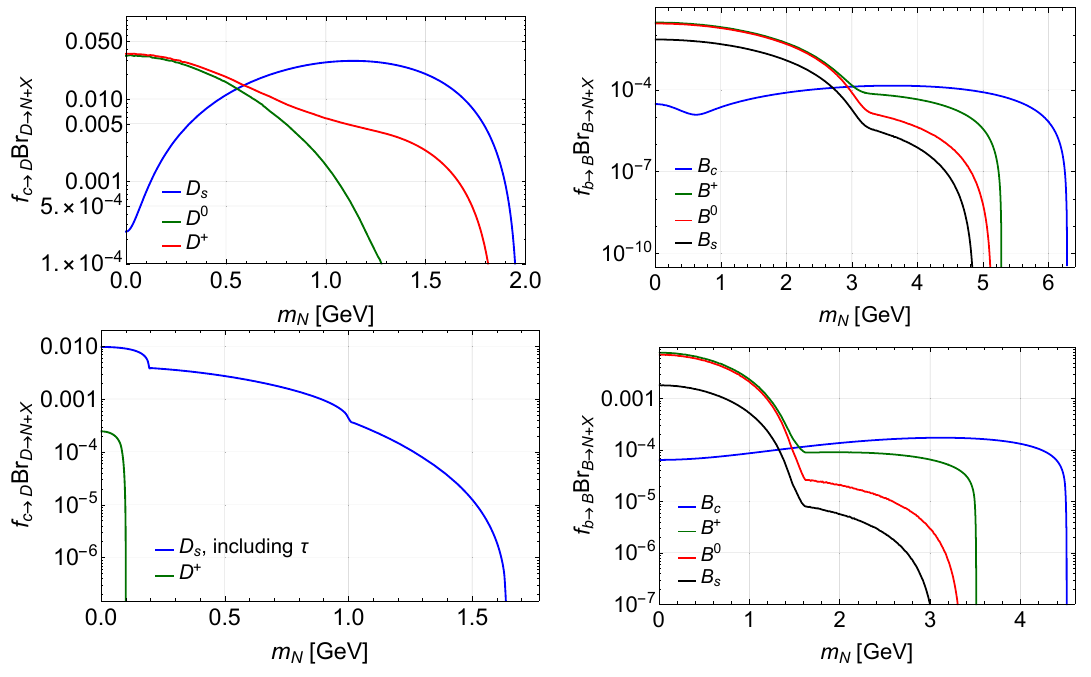
Figure 14 . Branching ratios multiplied by fragmentation fractions of D and B mesons decaying into HNL through e-type mixing (upper panel) and into the HNL through τ -type mixing (lower panel) for U 2 = 1. The values of fragmentation fractions are taken at LHC energies √ s = 13 TeV, see table